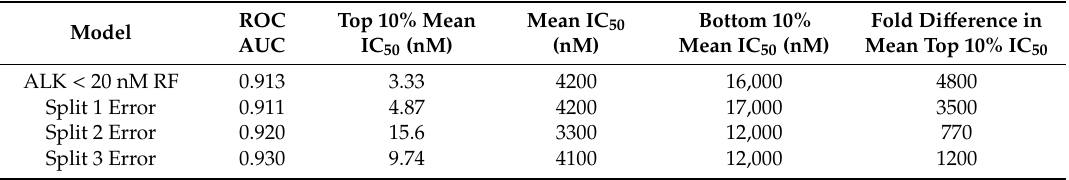
Table 12. Performance statistics for RFs with retained predictivity generated with 27% classification error in molecules between 109 nM and 3.7